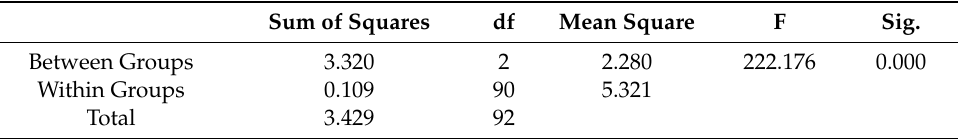
Table 3. ANOVA Table—self-leadership on SSB. Sum of Squares df Mean Square F Sig.